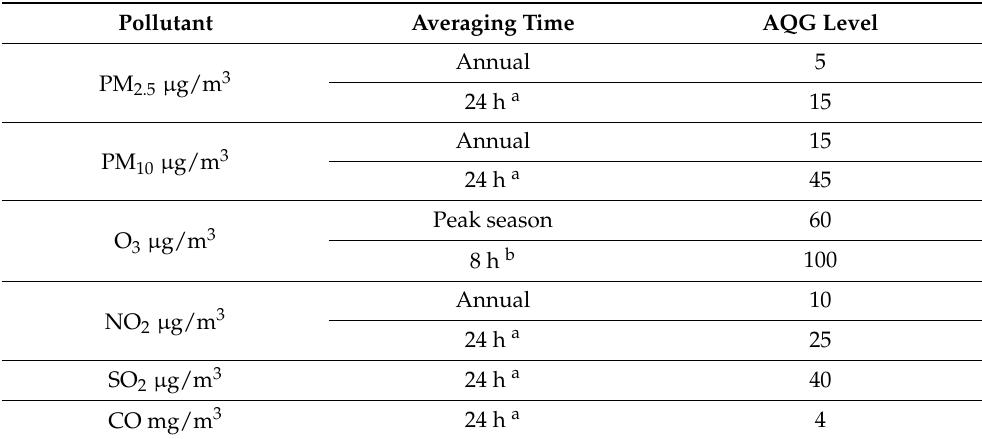
Table 1. Summary of recommended Air quality guideline (AQG) levels. Adapted from WHO Global air quality guidelines—2021